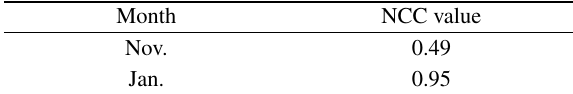
Table 14 NCC value between the Arabic tweets (classified as nonself) and count of actual hospital visits.